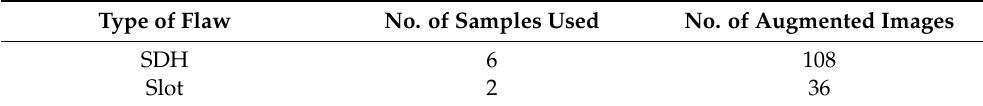
Table 3. Flaw wise augmented images